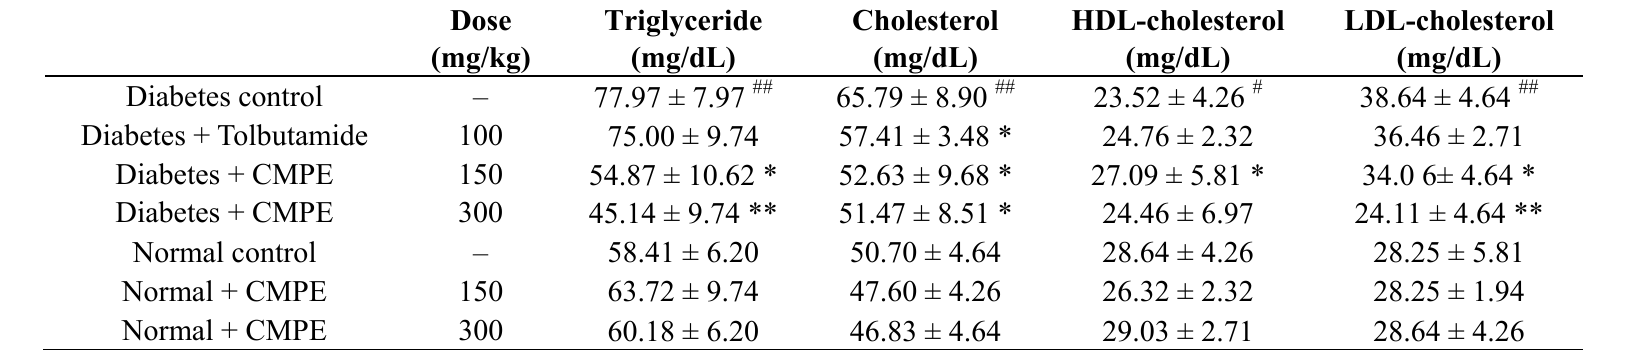
Table 2. Effects of CMPE on lipid profiles of normal and STZ induced diabetic